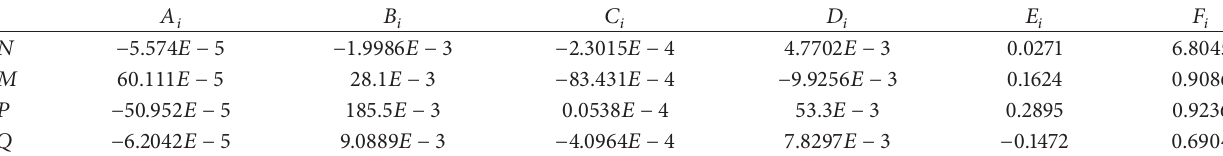
Table 1: Values of the coefficients of (10) [4].